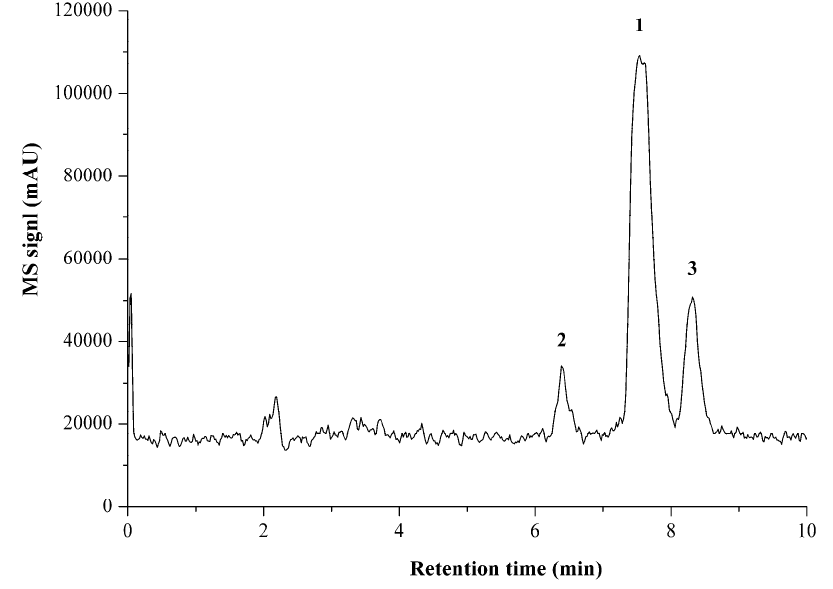
Figure 4. Representative LC-MS chromatogram of propionylbrassinolide TC under full scan model. 1 : propionylbrassinolide; 2 : impurity 1; 3 : impurity 2.